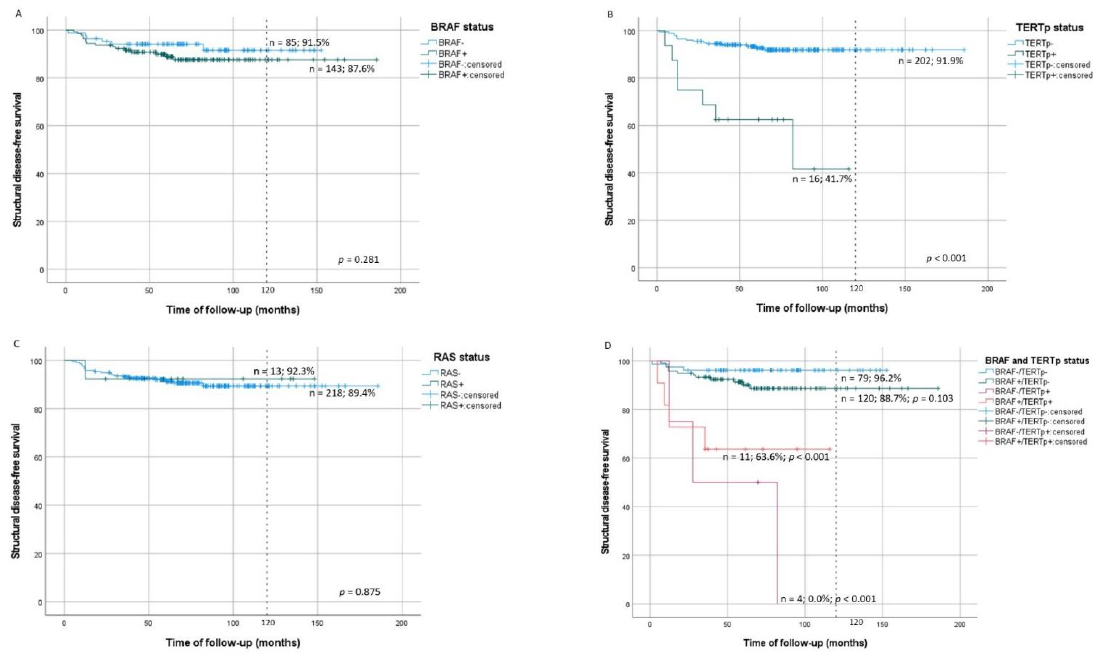
Figure 2. Kaplan–Meier survival curves of PTC structural disease-free survival (SDFS) by tumor molecular status in comparison with wild type tumors; ( A ) BRAF status, ( B ) TERTp status, ( C ) RAS status, ( D ) combined BRAF and TERTp status in comparison to wild-type tumors; wt: wild-type; mut: mutated.